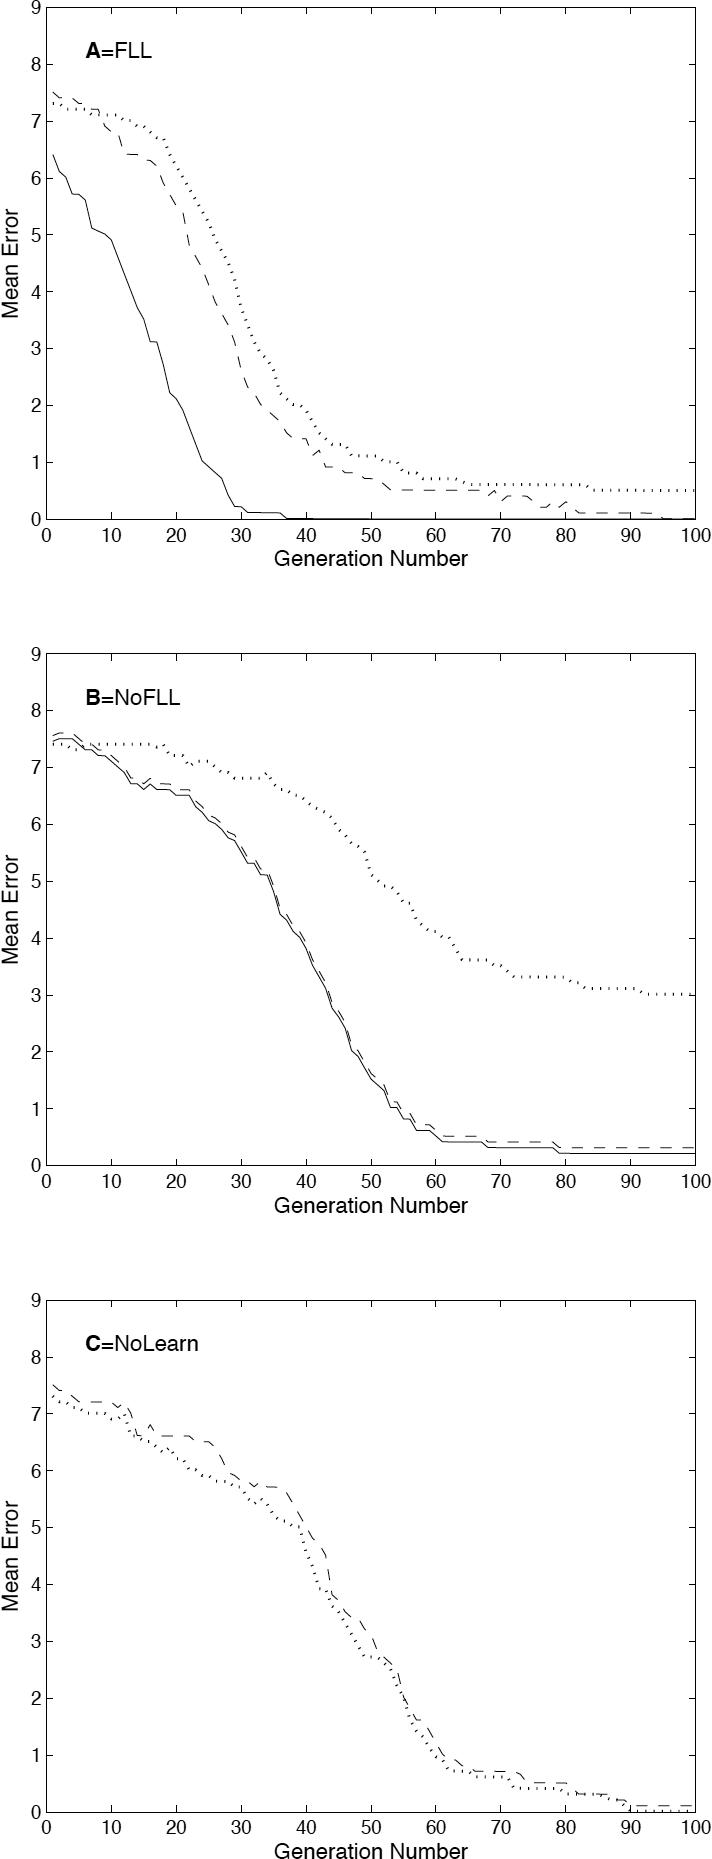
Effect of Free-Lunch Learning on EvolutionPerformance error in three conditions (FLL, NoFLL, and NoLearn). Different performance errors are drawn as follows: solid line, Epost(A
1), performance error on A
1 after learning only A
2;
dashed line, Epre(A
1), innate performance error on A
1; dotted line, Epre(A
2), innate performance error on A
2.(A) Condition FLL: mean performance error Epost(A
1) on A
1 (solid line) after learning A
2 decreased over generations most rapidly in this condition. Innate error on A
1 is slightly lower than on A
2.(B) Condition NoFLL: precluding FLL ensured that mean innate error on A
1 (dashed line) was essentially the same as after learning A
2 (solid line). The dashed line has been plotted 0.1 units above the solid line for clarity. Innate error on A
2 is large because the fitness cost of innate errors is low (c = 0.05).(C) Condition NoLearn: mean innate performance error Epre(A
1) and Epre(A
2) on A
1 and A
2. For comparison, mean performance errors on A
1 in each condition (i.e., the solid lines here) are summarised in Figure 4.